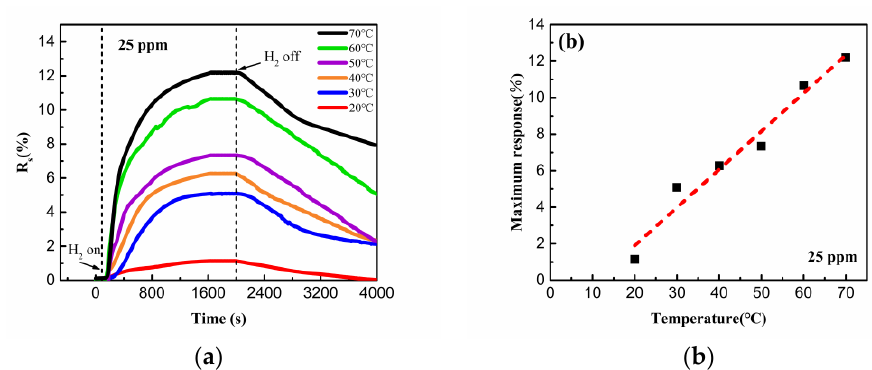
Figure 7. ( a ) The response of the sensor under 25 ppm H 2 at different temperatures. ( b ) The maximum response as a function of measurement temperature.